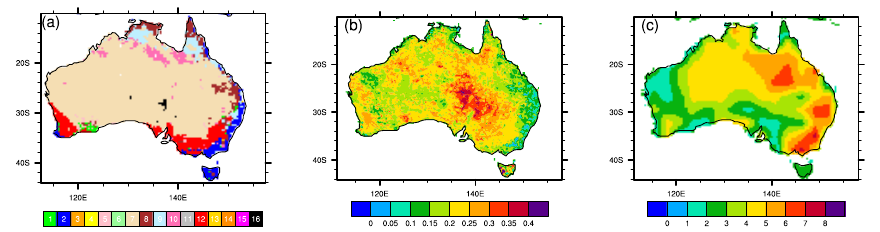
Figure 2. (a) Distribution of PFTs in the domain, (b) prescribed background-snow-free soil albedo from Houldcroft et al. (2009) used in the CNTL experiment, and (c) soil colours used in the PSALB experiment. The PFTs in panel (a) are shown in Table 2.